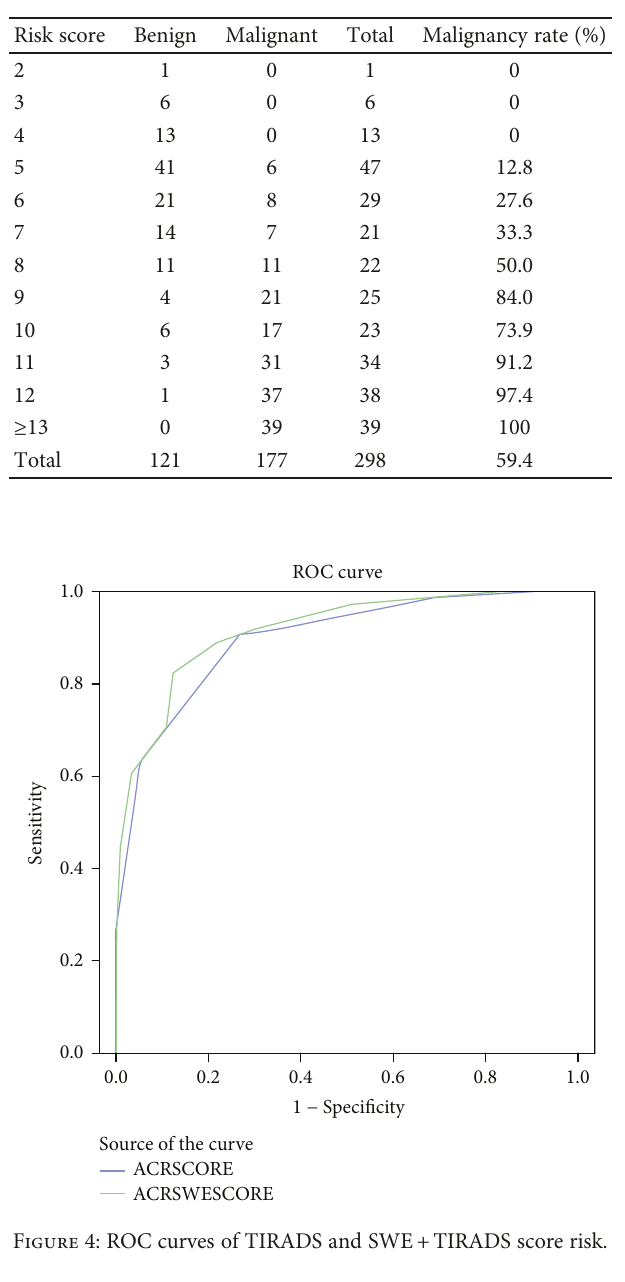
Table 7: Distribution of 298 thyroid lesions based on SWE+ TIRADS scores.